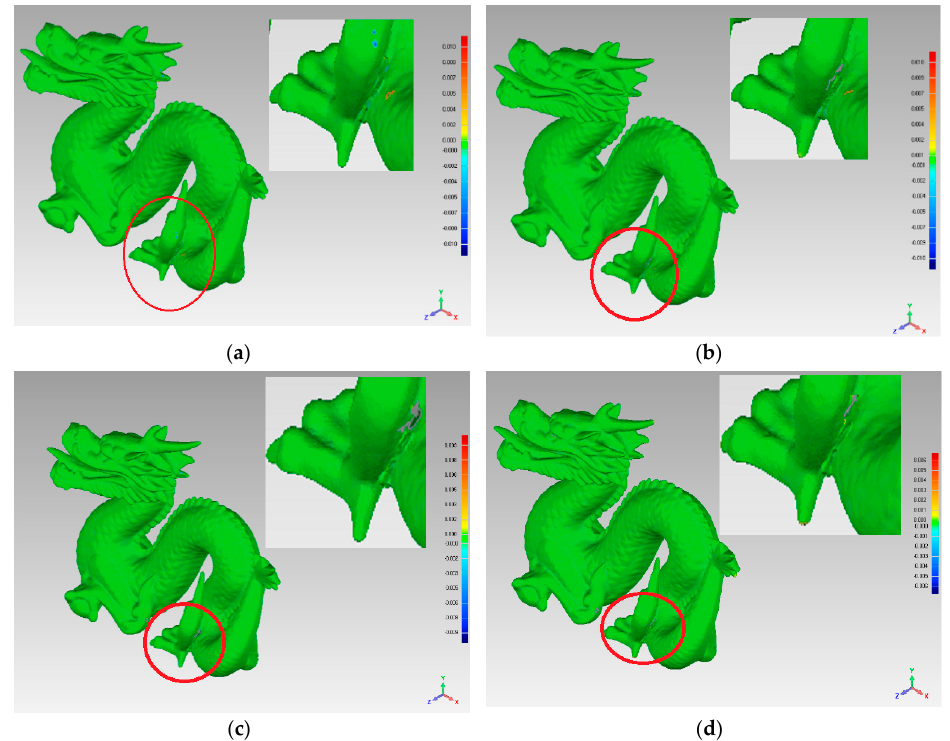
Figure 14. Simplification effect comparison of four simplification algorithms using the dragon data set: ( a ) uniform-based simplification algorithm; ( b ) grid-based simplification algorithm; ( c ) curvature-based simplification algorithm; ( d ) FPPS.